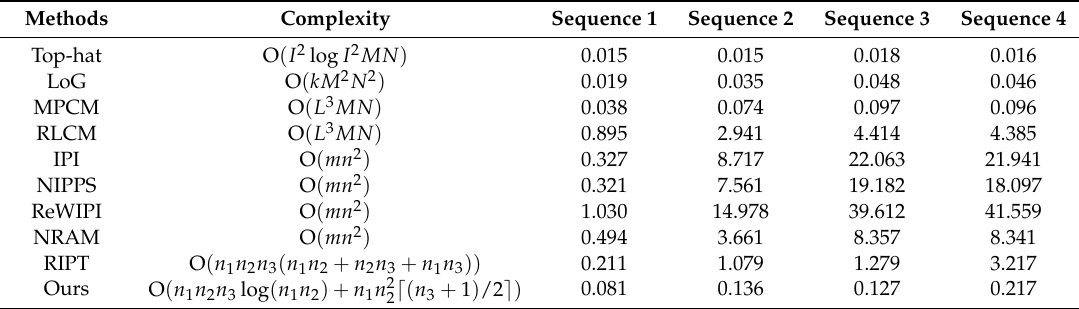
Table 7. Comparison of computational complexity and average computing time (in seconds) of the 10